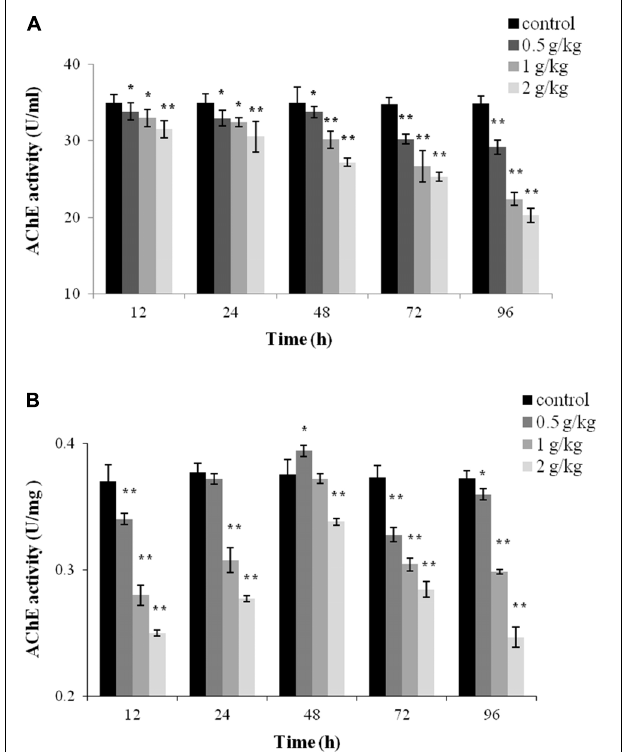
FIGURE 2 | Acetylcholinesterase (AChE) activity in Carassius auratus gibelio after a single dose of 0.5 g/kg, 1 g/kg, or 2 g/kg trichlorfon. (A) Changes in AChE activity in plasma after a single dose of trichlorfon; (B) changes in AChE activity in liver tissues after a single dose of trichlorfon. Asterisks indicate values that are significantly different from the control values, ∗ P < 0.05; ∗∗ P < 0.01, n = 3.